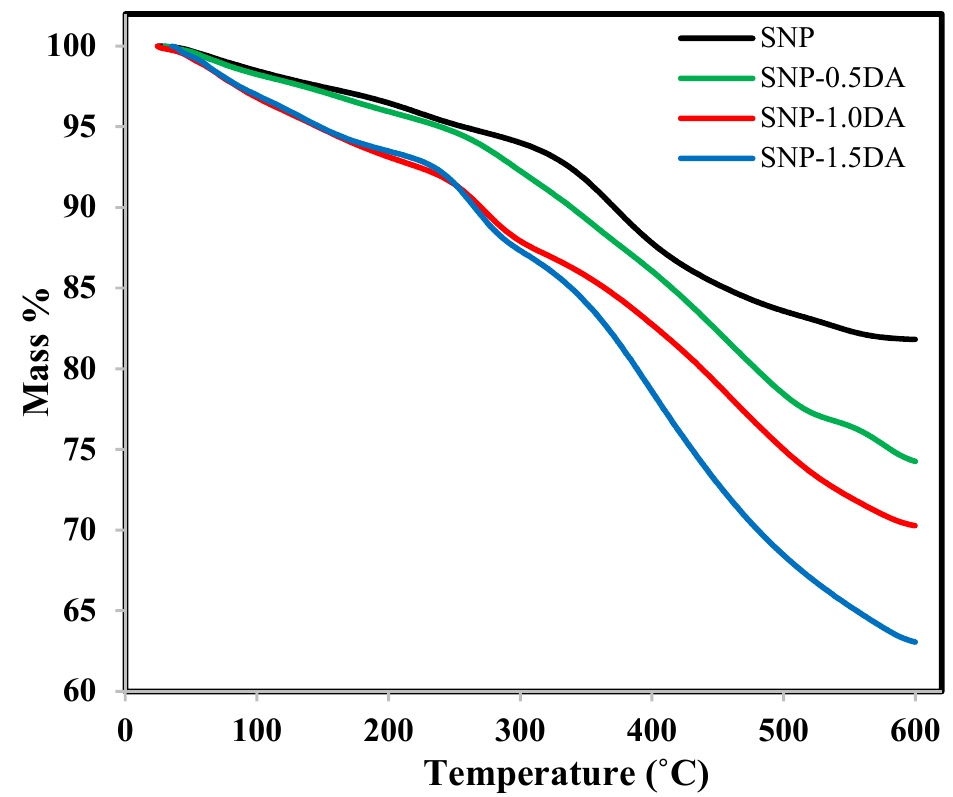
Figure 3. TGA profile for the four nanocomposites over the temperature range of 20–600 ◦ C.